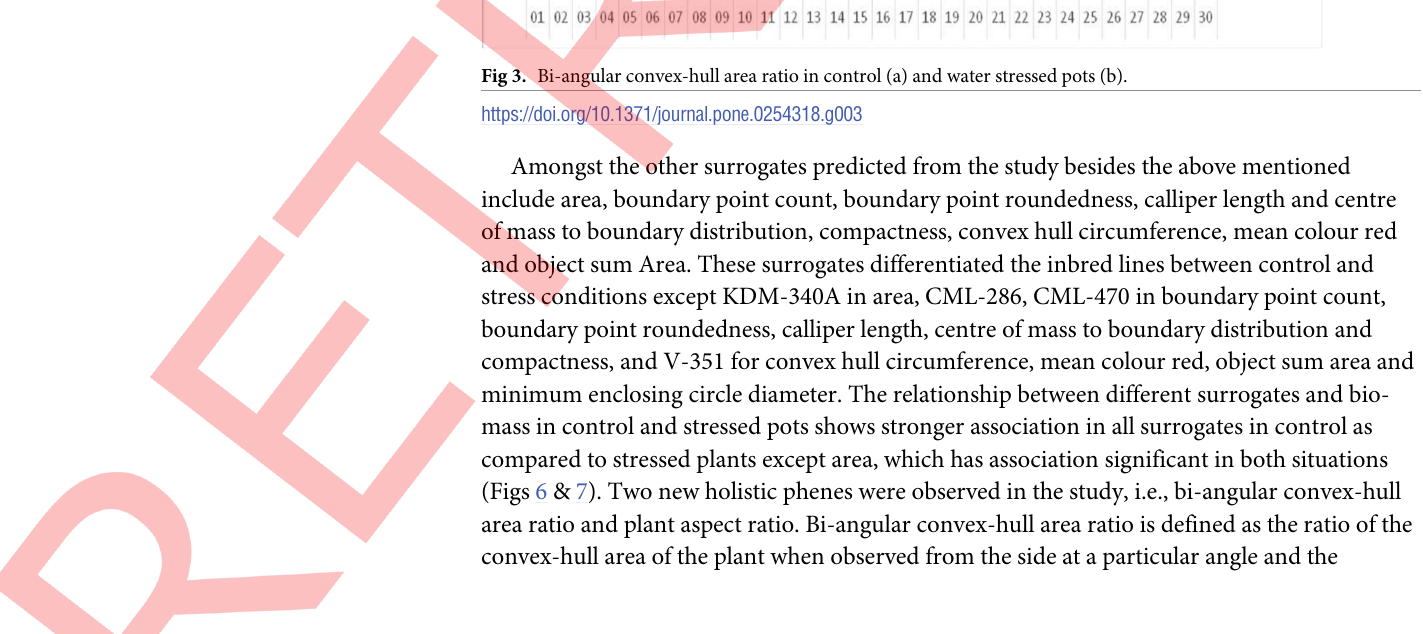
Fig 3. Bi-angular convex-hull area ratio in control (a) and water stressed pots